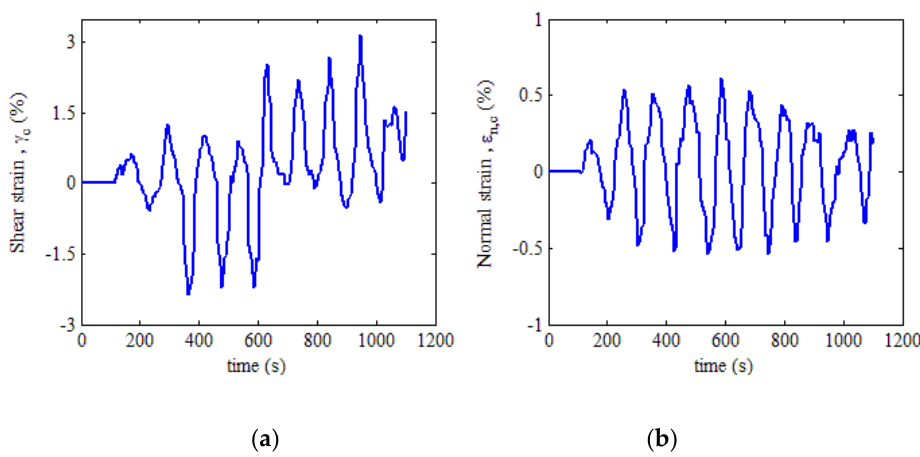
Figure 12. Strain response on the critical damage plane: ( a ) shear strain; ( b ) normal strain. Based on the obtained strain responses on the critical damage plane, the double rain flow counting method can be used to compile the load spectrums of variable amplitude fatigue. In practice, the number of cycles, shear strain range ∆ γ , and the shear mean strain γ m are counted first, and the turning point of each cycle is also determined. The peaks of the dotted line are the turning points as shown in Figure 13a. Then, the maximum normal strain range ∆ ε and the normal mean strain ε m between adjacent turning points are calculated from the normal strain response on the critical plane, as shown in Figure 13b.